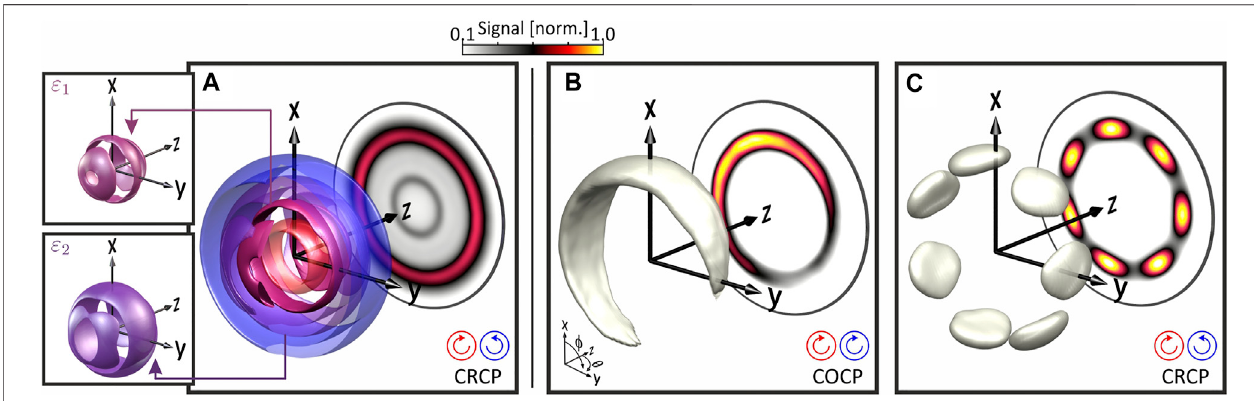
FIGURE 9 | Tomographically reconstructed 3D PMDs of free electron wave packets created by MPI of potassium and sodium atoms with circularly polarized bichromaticpulses. (A) Intrabandinterferencesandsingle-colorcontributionsfromMPIofpotassiumusingCRCPbichromatic fi eldswithincommensurablefrequencies. (B) FEV with c 1 rotational symmetry from interband interference in the MPI of sodium using CEP-stable COCP (3 ω :4 ω ) bichromatic fi elds. (C) FEV with c 7 rotational symmetry created by MPI of sodium using CRCP (3 ω :4 ω ) fi elds.